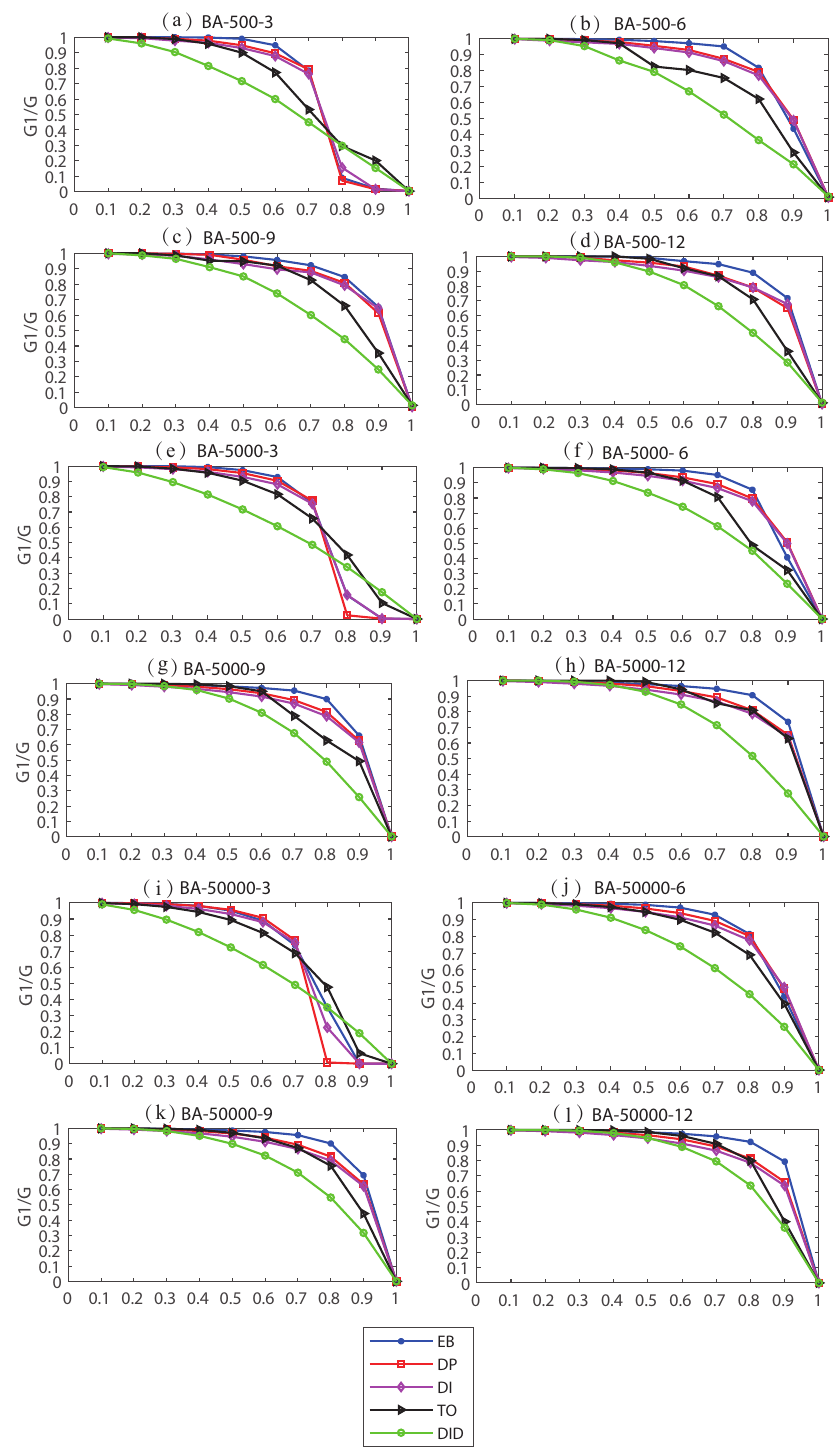
Figure 3. The dynamic damage of DID and 4 comparison algorithms to BA networks connectivity ( a – l